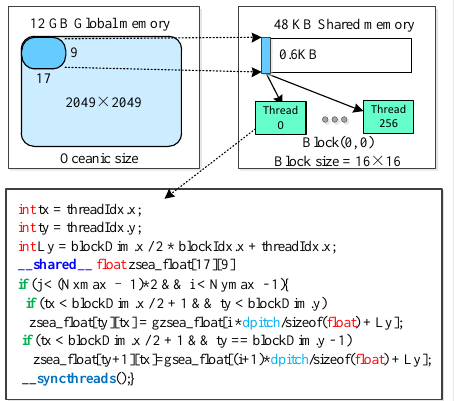
Figure 8. Schematic of the usage of shared memory in place of global memory for data transfers between global memory and the